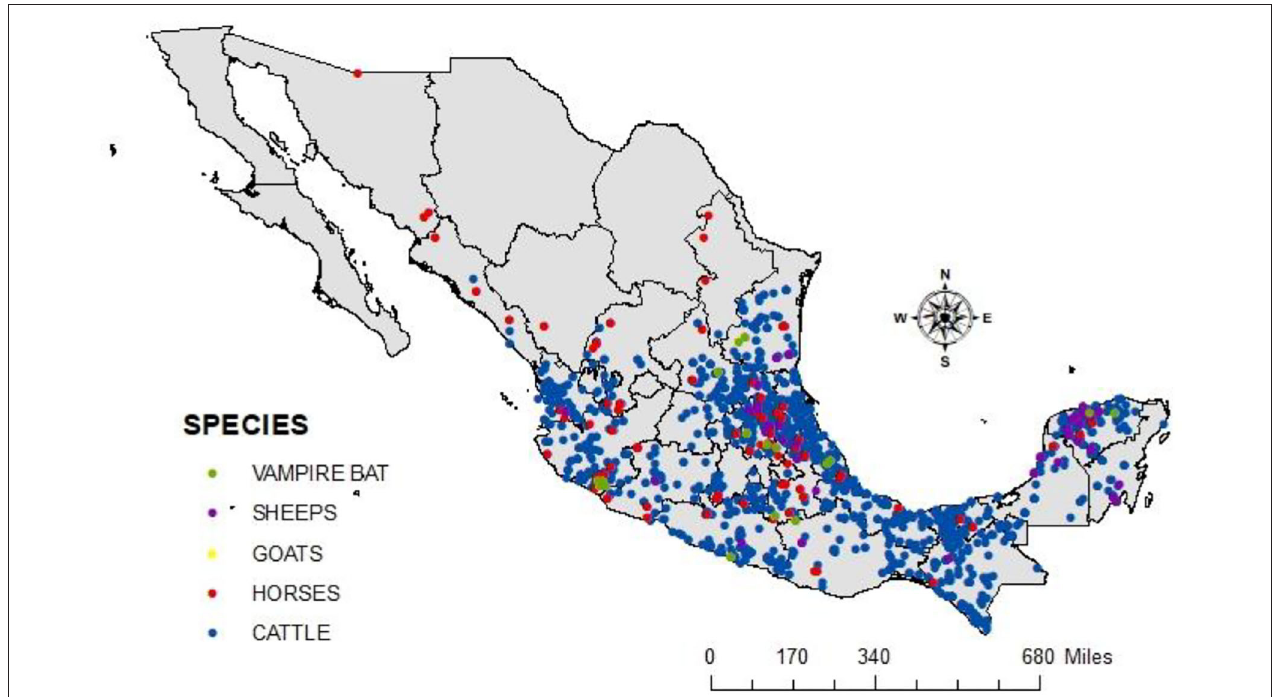
FIGURE 4 | The spatial distribution of cases in livestock species and vampire bats from 2010 to 2019. Rabies cases in cattle are shown in blue, horses in red, vampire bats in green, goats in yellow, and sheep in purple.